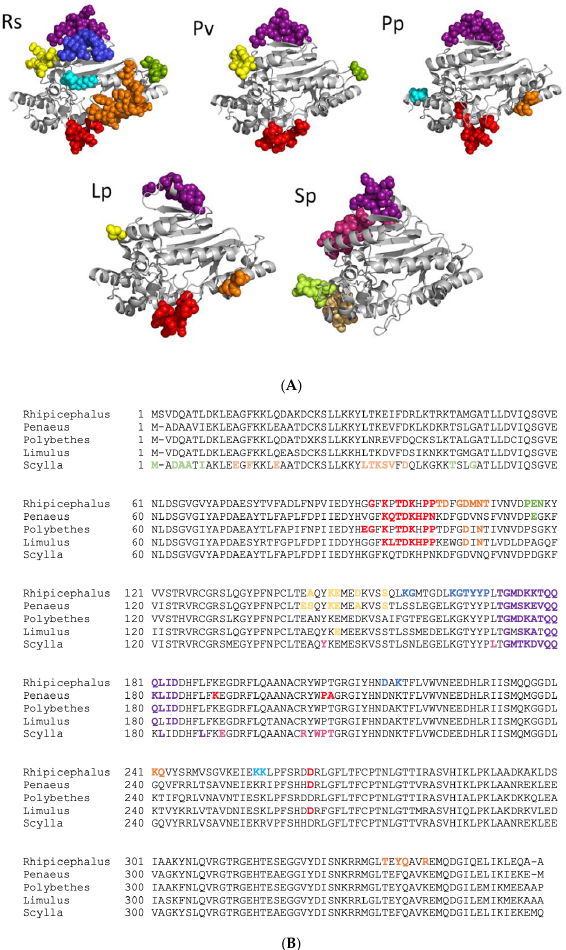
Figure 4. Identification of epitopes in the sequence and structure of AKs. ( A ): Epitopes predicted by DiscoTope shown in the structural models of invertebrates AKs ( B ): linear amino acid sequence alignment (panel B). Rs stands for R. sanguineus , Lv for L. vannamei , Pp for P. pytagoricus , Lp for L. polyphemus , and Sp for S. paramamosain . Colors match both structural models and linear amino acid sequences.